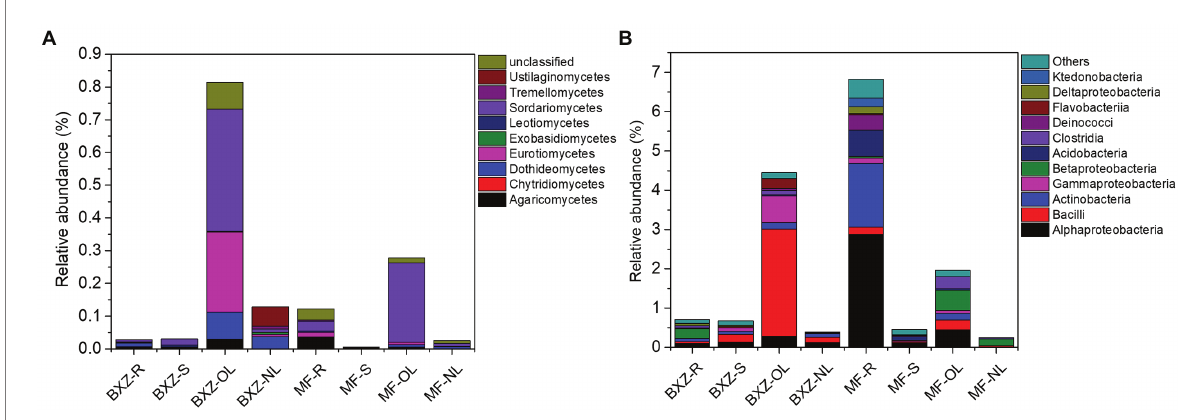
FIGURE 6 Specific bacterial (A) and fungal (B) endophytic communities that only occurred in specific tissue/cultivar (class level). BXZ_R, BXZ_S, BXZ_OL and BXZ_NL represented root, stem, old leave and new leave samples of BXZ cultivar. while MF_R, MF_S, MF_OL and MF_NL represented root, stem, old leave and new leave samples for MF